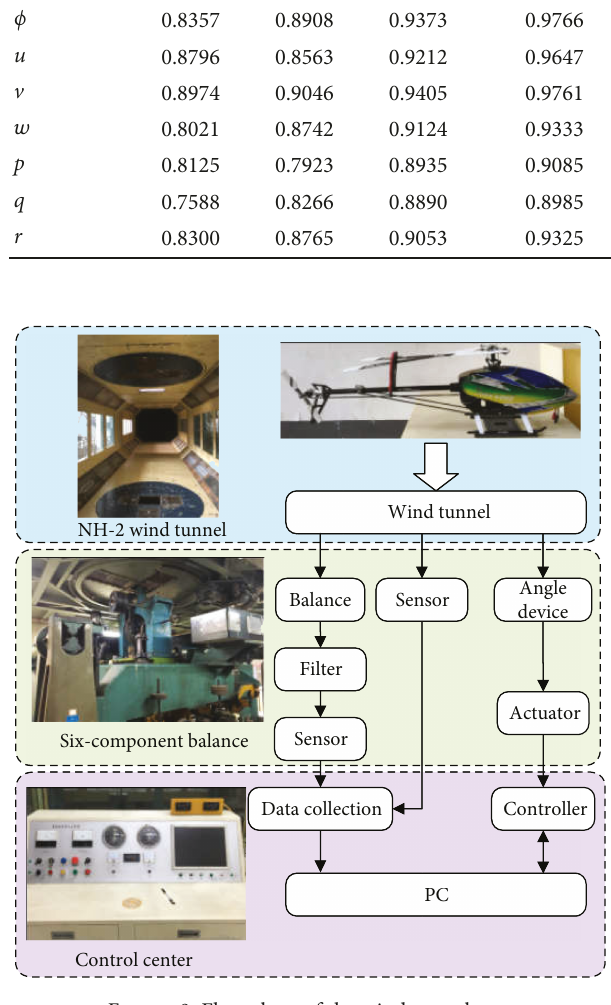
Figure 9: Flow chart of the wind tunnel test.